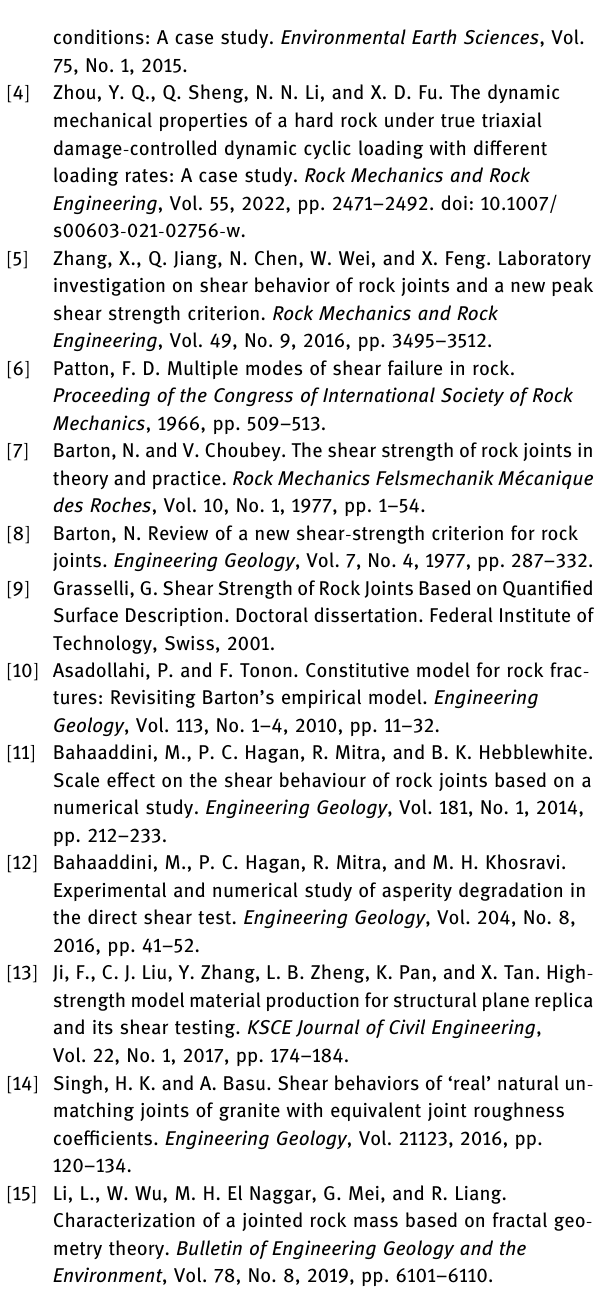
Table 3: Comparison of the experimental value of shear strength and the prediction value of the theoretical model No. Normal stress ( MPa ) Shear strength based on tests M p3D Shear strength based on prediction model